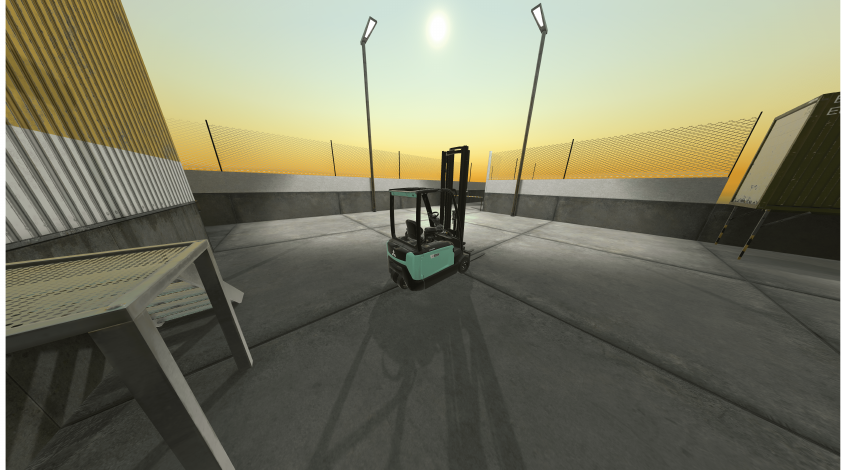
Figure 9. A fork lift model in its environment as an example of a combination between a real-time simulation software and Unity